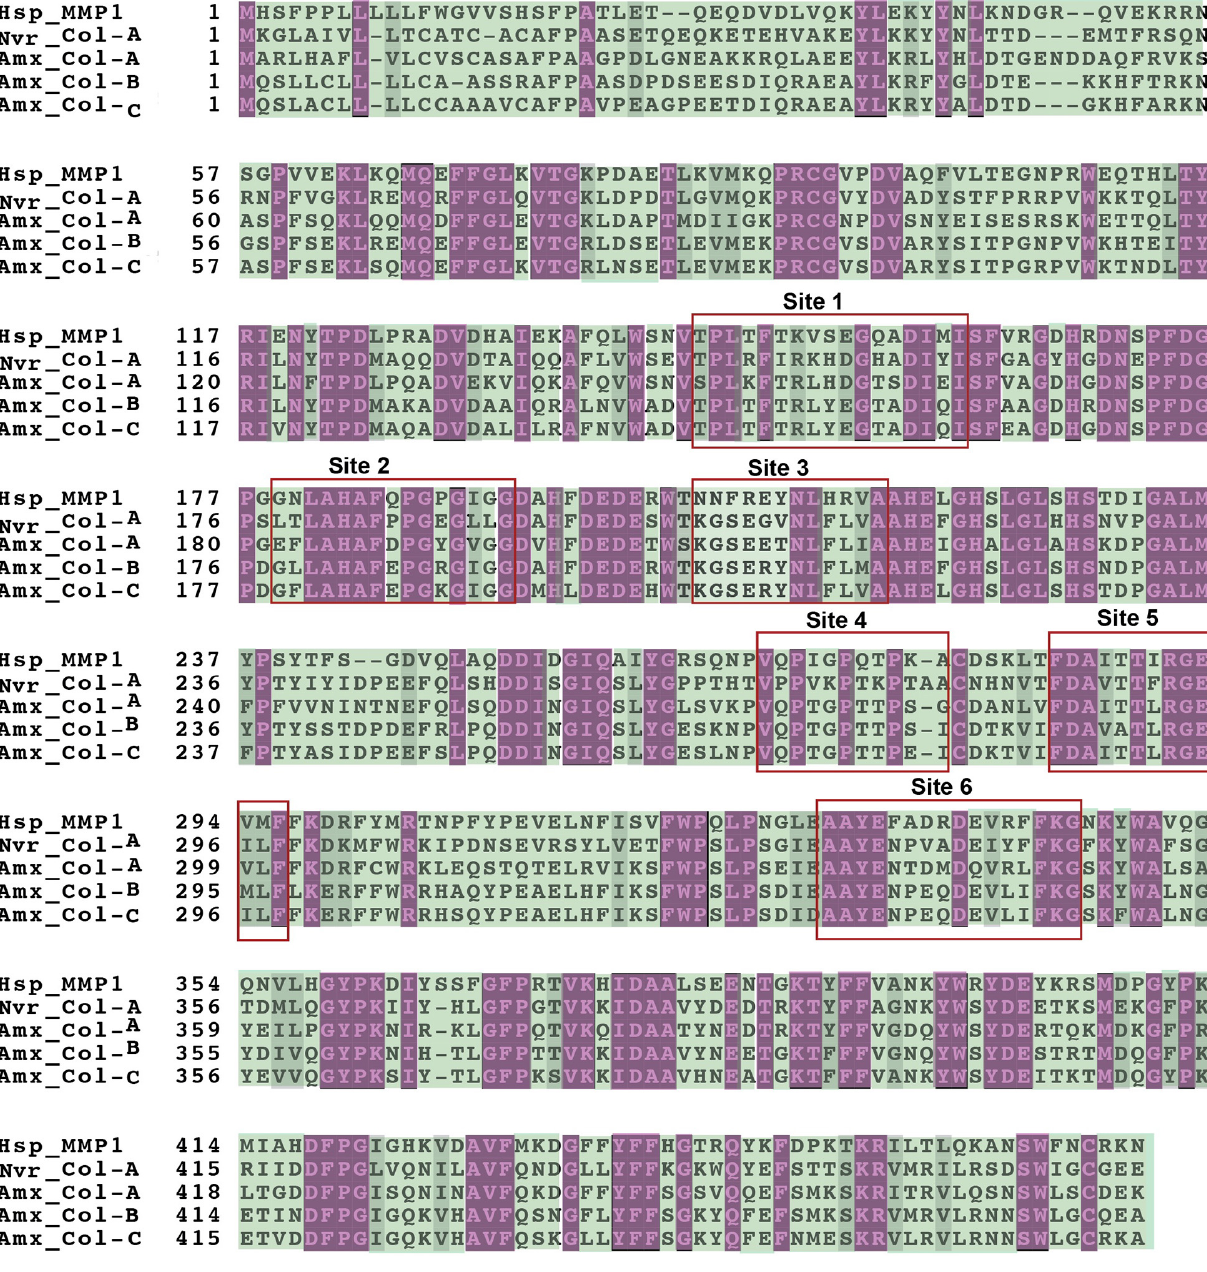
FIGURE 4 | Multiple sequence alignment of the peptide sequence of human MMP1, Nvir-Col-A, and axolotl Col-A, Col-B, and Col-C. Purple and green highlighted regions reflect conserved and variable amino acid residues,